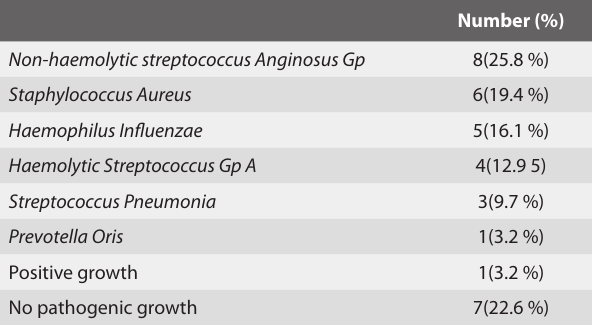
Table 3. Microbiology culture results from the 31 patients obtained dur- ing surgery.